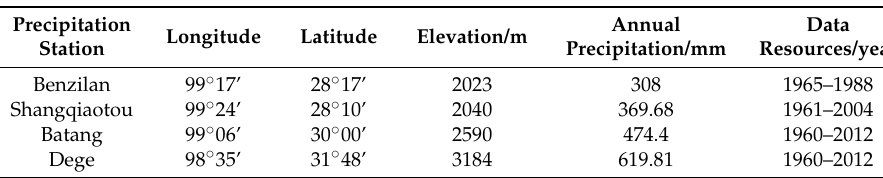
Table 2. Annual precipitation measured by precipitation stations along the upstream of the Jinsha River at different elevation.